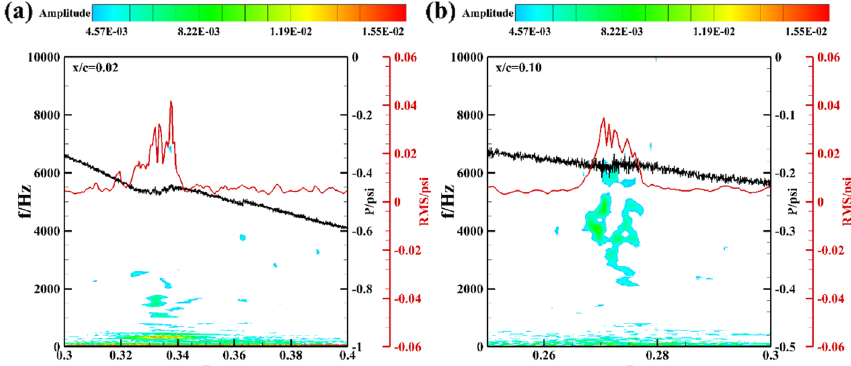
Fig. 6 Wavelet analysis at typical locations. a x / c